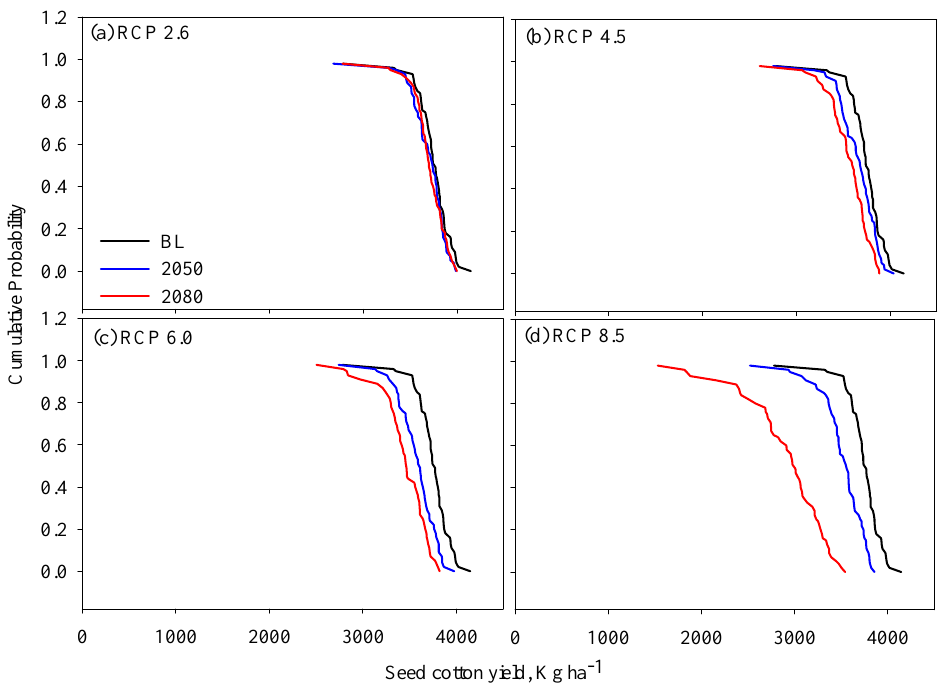
Figure 7. Simulated impacts of temperature rises alone on irrigated seed cotton yield in 2050 and 2080 under RCP 2.6 ( a ), 4.5 ( b ), 6.0 ( c ), and 8.5 ( d ) greenhouse gas (GHG) scenarios. Projected changes in both maximum and minimum temperatures alone were considered assuming no CO 2 and rainfall changes.